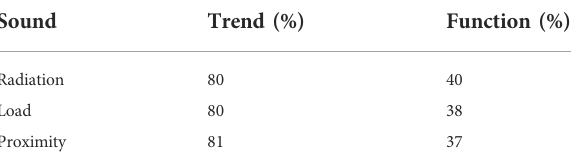
TABLE 3 The mean distance from the target location for each of the data parameters. Hence, the lower the distance the better the set